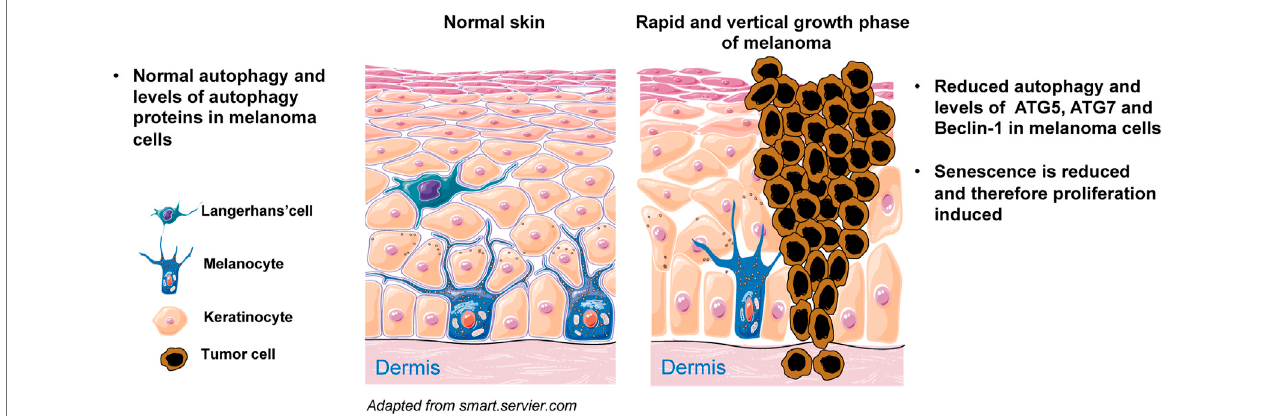
FIGURE 5 | Simpli fi ed scheme of melanoma initiation. Melanocytes are normally regulated by epidermal keratinocytes and produce physiological levels of ATGs and autophagy. Melanocytes can proliferate abnormally in response to oncogenic mutations and cluster along the basement membrane of the epidermis. Cells